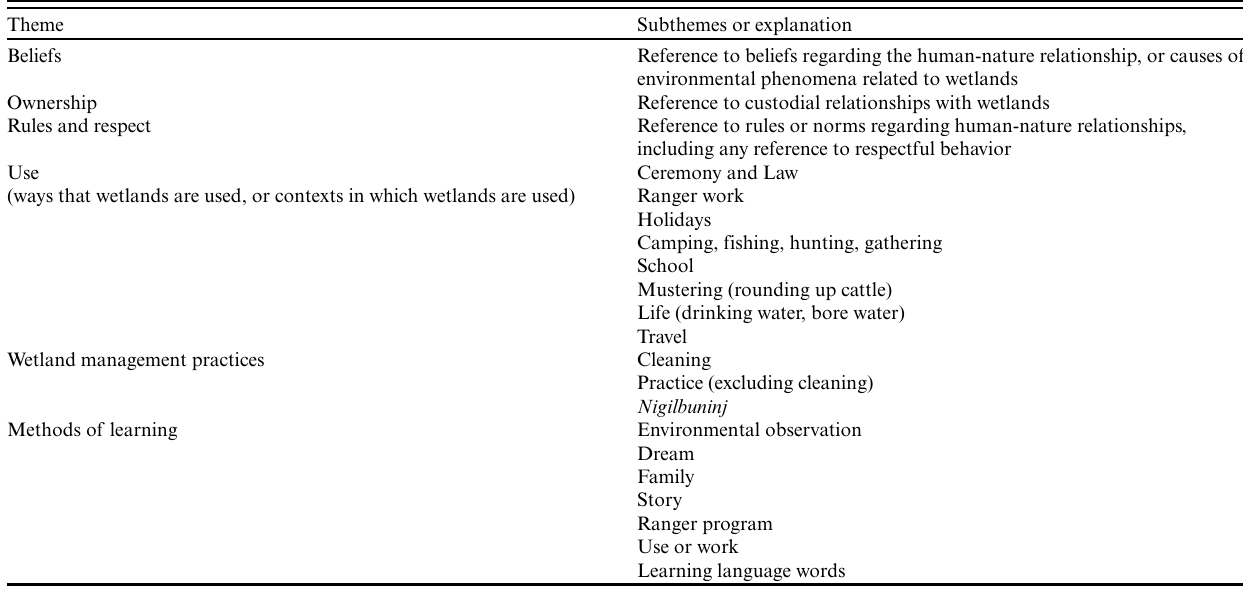
Table 3 . Coding frame used to analyze all qualitative data (interview transcripts, observational notes, and transcripts of